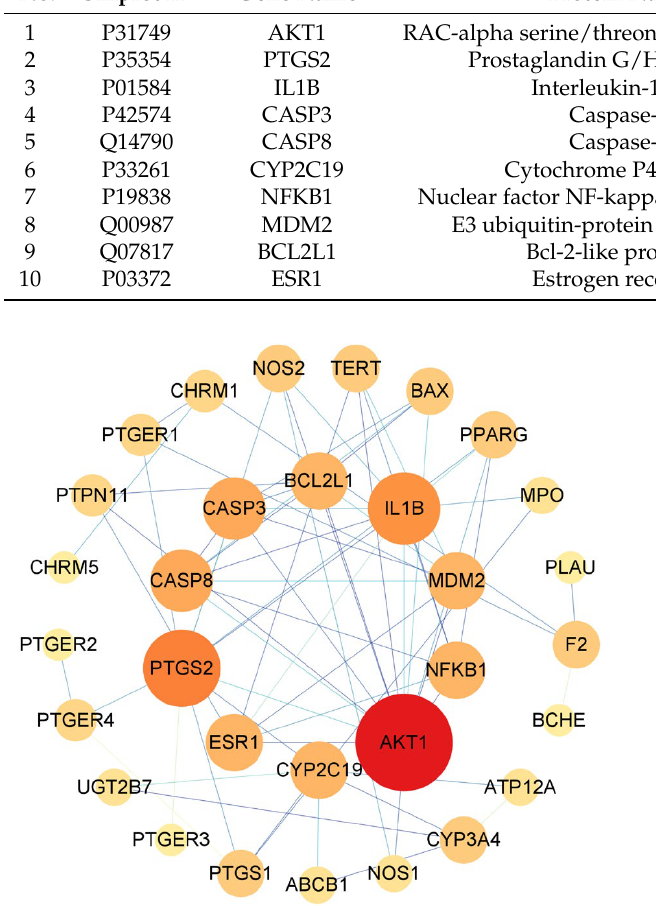
Figure 4. The PPI analysis of targets between AR and GU. The node size and color are proportional to the target degree in the network. to the target degree in the